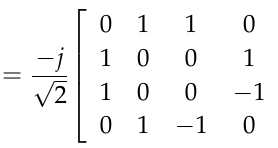
Figure 9. Experimental phase difference between the output signal on port 4 and 6 when port 1 is fed.